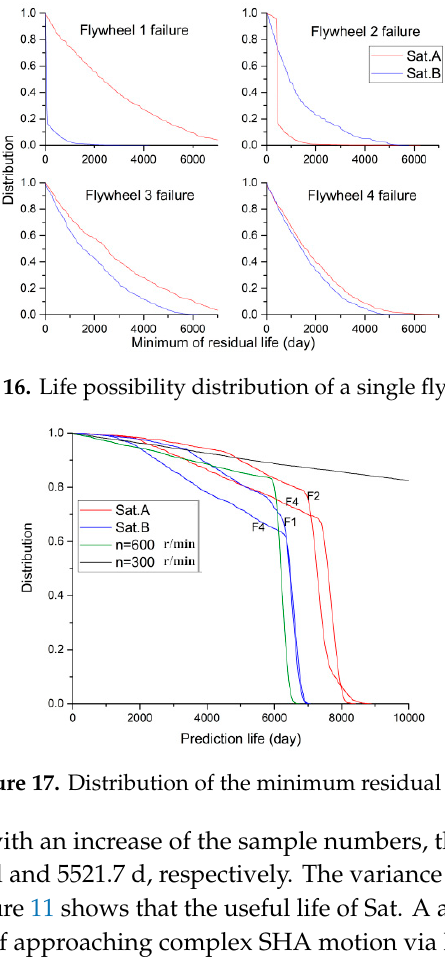
Figure 15. Conditional distribution of N2.